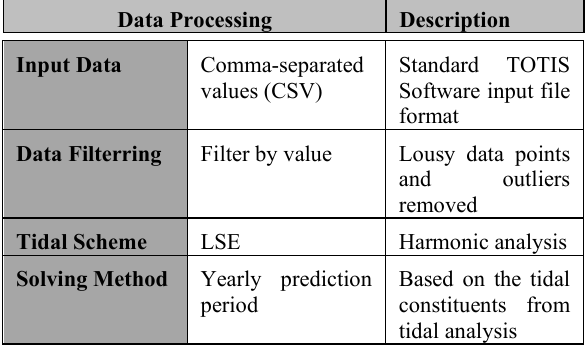
Table 2. The analysis and prediction strategies using TOTIS